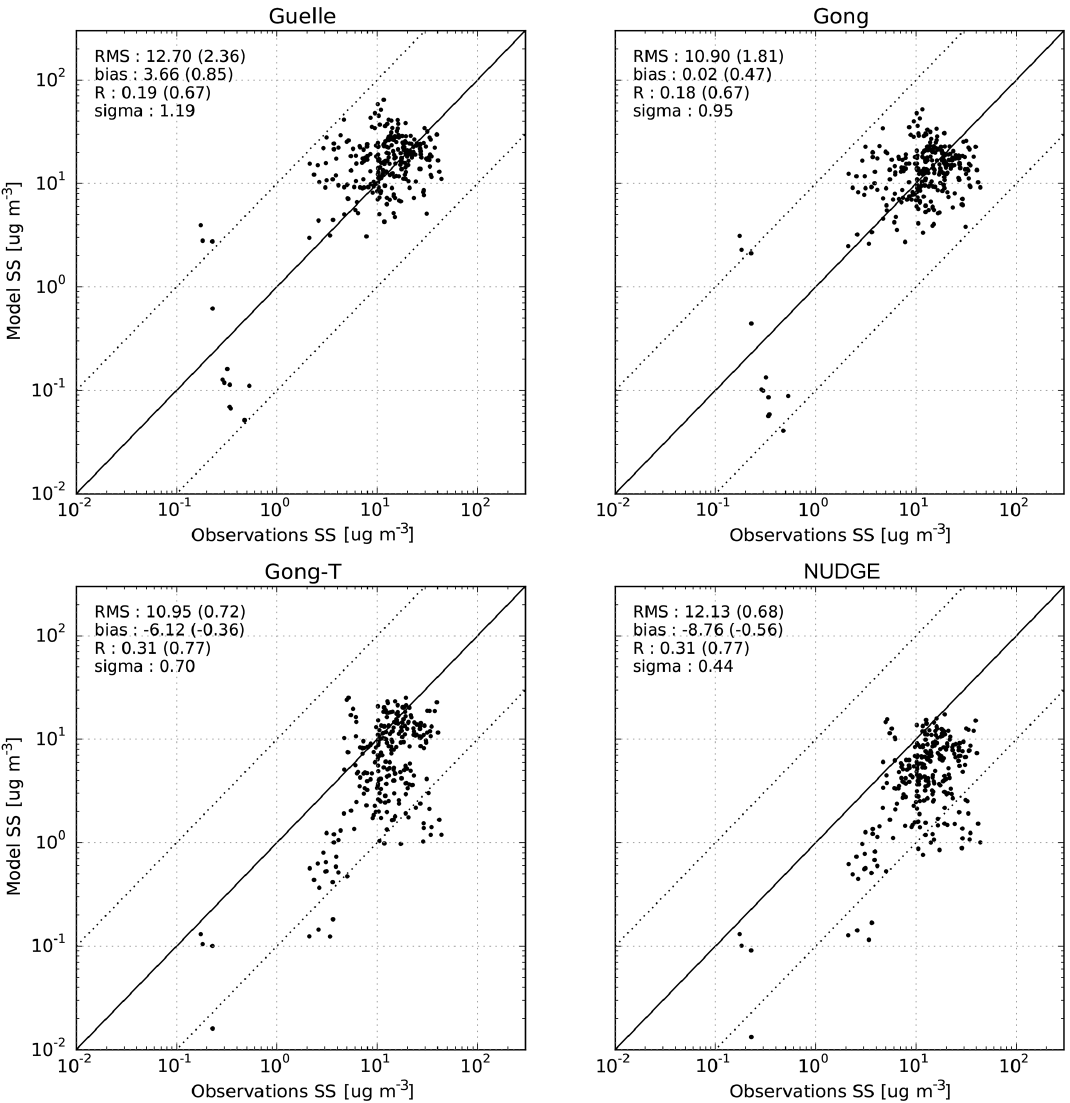
Figure 23. Scatterplot of observed versus simulated monthly mean sea salt surface concentrations at the AEROCE and SEAREX stations shown in Fig. 17 for 2010. Compared are simulations using different sea salt emission parameterizations (Guelle, Gong, Gong-T,